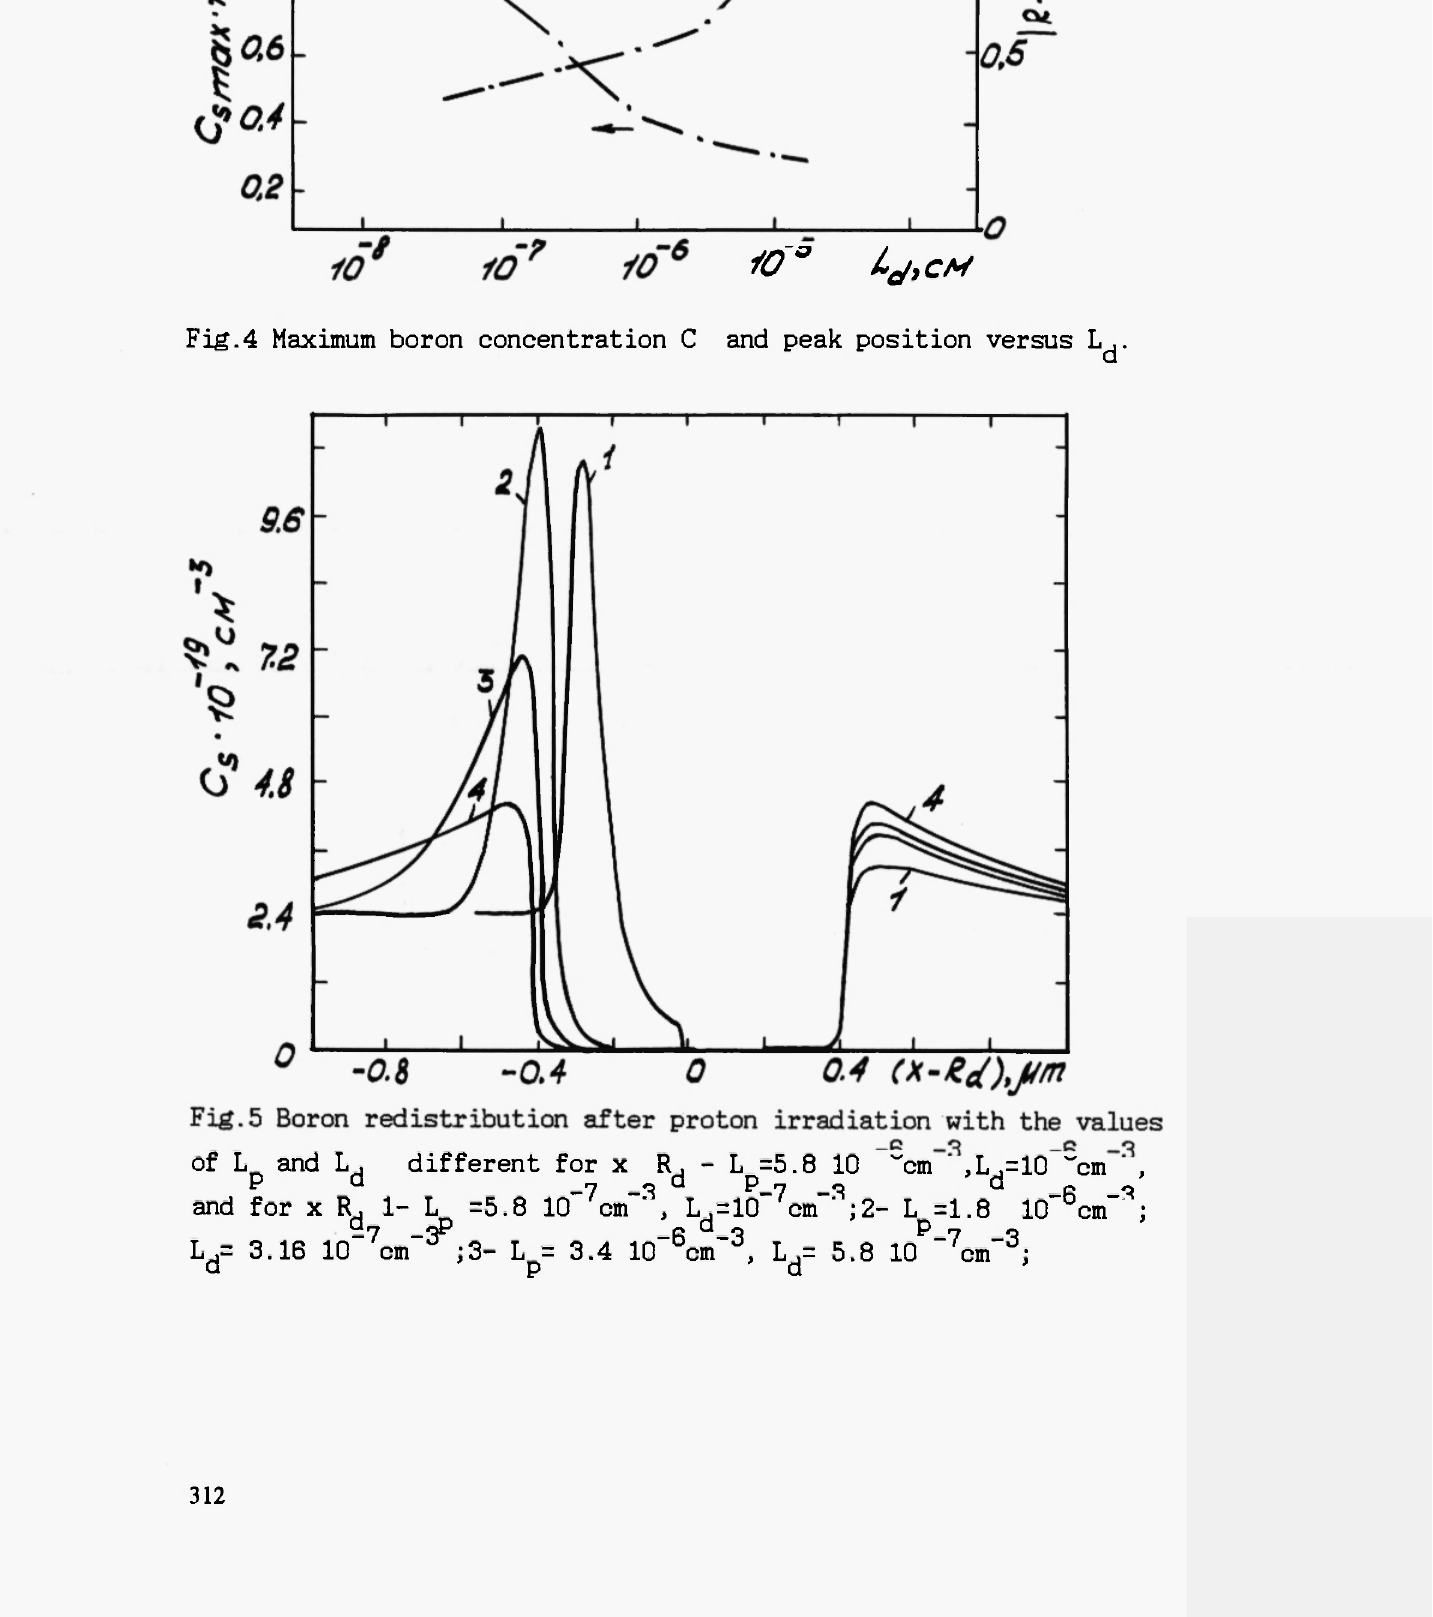
Fig.4 Maximum boron concentration C and peak position versus